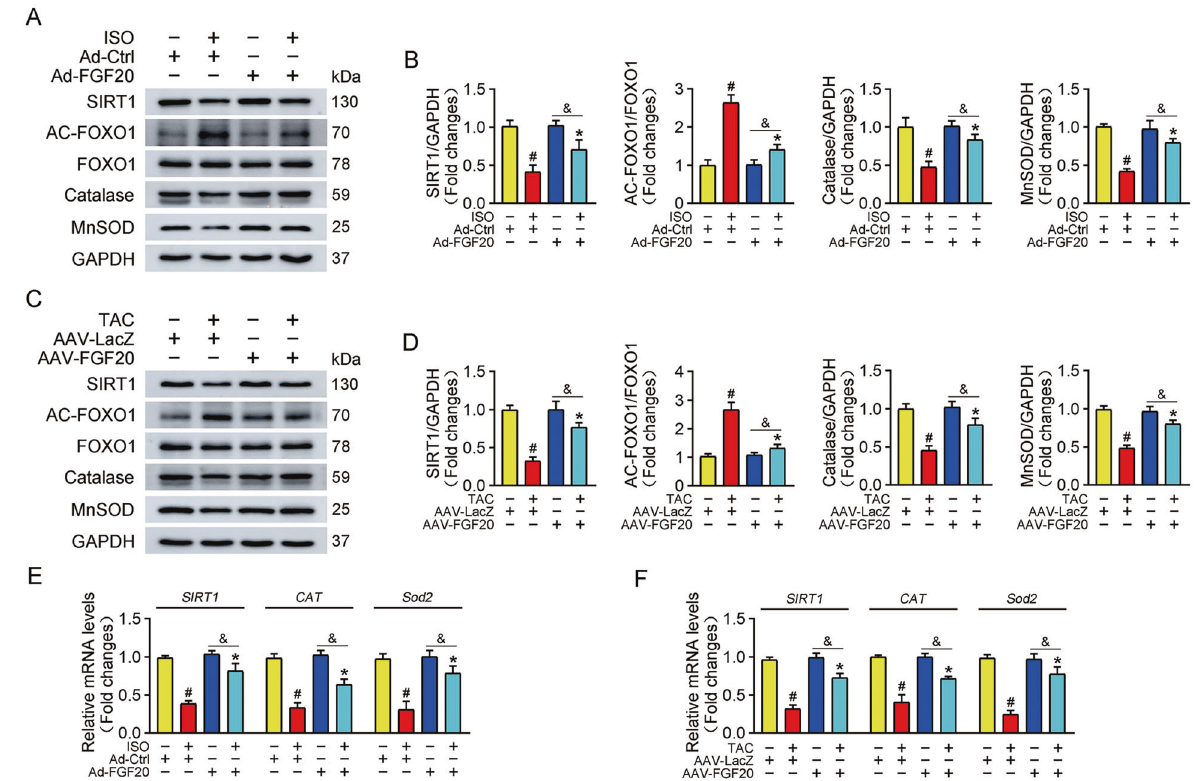
Fig. 5 SIRT1 is the effective executor of FGF20 in myocardial protection. A Western blot was performed to determine the protein levels of SIRT1, AC-FOXO1, FOXO1, Catalase, and MnSOD in NRCMs transfected with Ad-Ctrl or Ad-FGF20 in the presence or absence of ISO. B Quantitative analysis of expressions of SIRT1, AC-FOXO1, FOXO1, Catalase, MnSOD in A . n = 5 per group, # P < 0.05 versus Ad-Ctrl group, * P < 0.05 versus Ad-Ctrl + ISO group. Data represent means ± SEM, Two-tailed Student ’ s t test. C Western blot was performed to determine the protein levels of SIRT1, AC-FOXO1, FOXO1, Catalase, and MnSOD in the hearts of mice infected with AAV-LacZ or AAV-FGF20 and subjected Sham or TAC operation. D Quantitative analysis of expressions of SIRT1, AC-FOXO1, FOXO1, Catalase, MnSOD in C . n = 5 per group, # P < 0.05 versus AAV-LacZ + Sham group, * P < 0.05 versus AAV-LacZ + TAC group. Data represent means ± SEM, Two-tailed Student ’ s t test. E RT-qPCR analysis of the mRNA levels of SIRT1, CAT, and Sod2 in NRCMs transfected with Ad-Ctrl or Ad-FGF20 in the presence or absence of ISO. n = 5 per group, # P < 0.05 versus Ad-Ctrl group, * P < 0.05 versus Ad-Ctrl + ISO group, & P < 0.05 versus Ad-FGF20 group. Data represent means ± SEM, Two-tailed Student ’ s t test. F RT-qPCR analysis of the mRNA levels of SIRT1, CAT and Sod2 in the hearts of mice infected with AAV-LacZ or AAV- FGF20 and subjected Sham or TAC operation. n = 5 per group, # P < 0.05 versus AAV-LacZ + Sham group, * P < 0.05 versus AAV-LacZ + TAC group, & P < 0.05 versus AAV-FGF20 + Sham group. Data represent means ± SEM, Two-tailed Student ’ s t